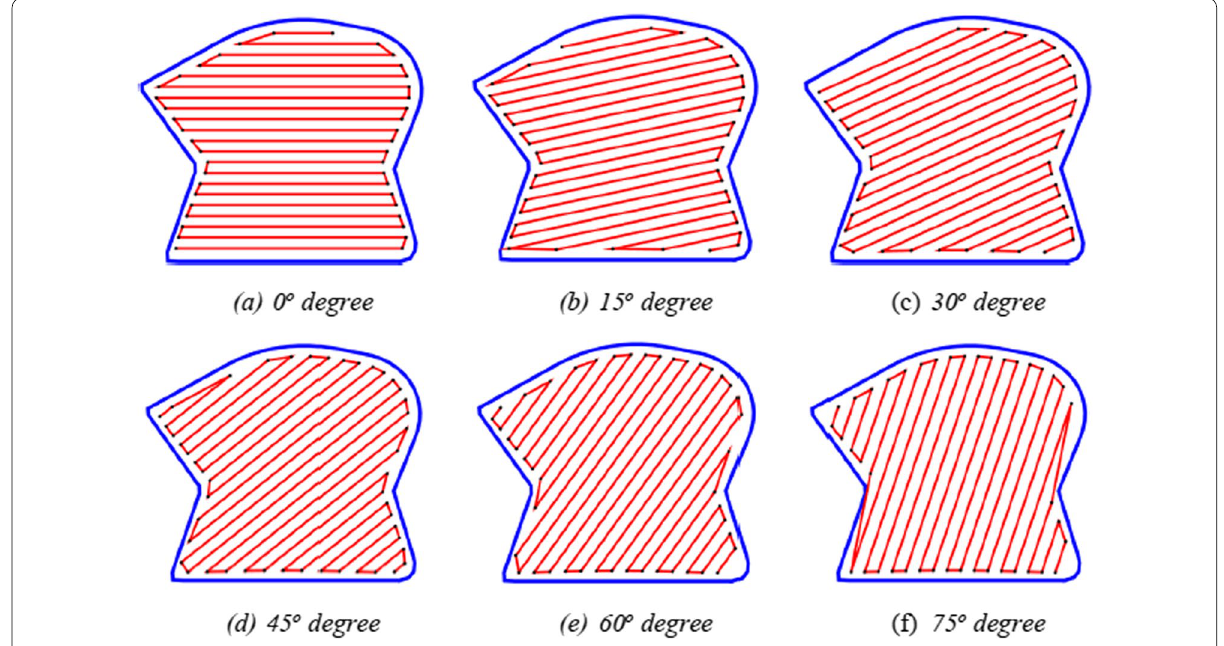
Fig. 13 Incremental of zigzag slopes for the same layer in example (2). a 0°; b 15°; c 30°; d 45°; e 60°; f